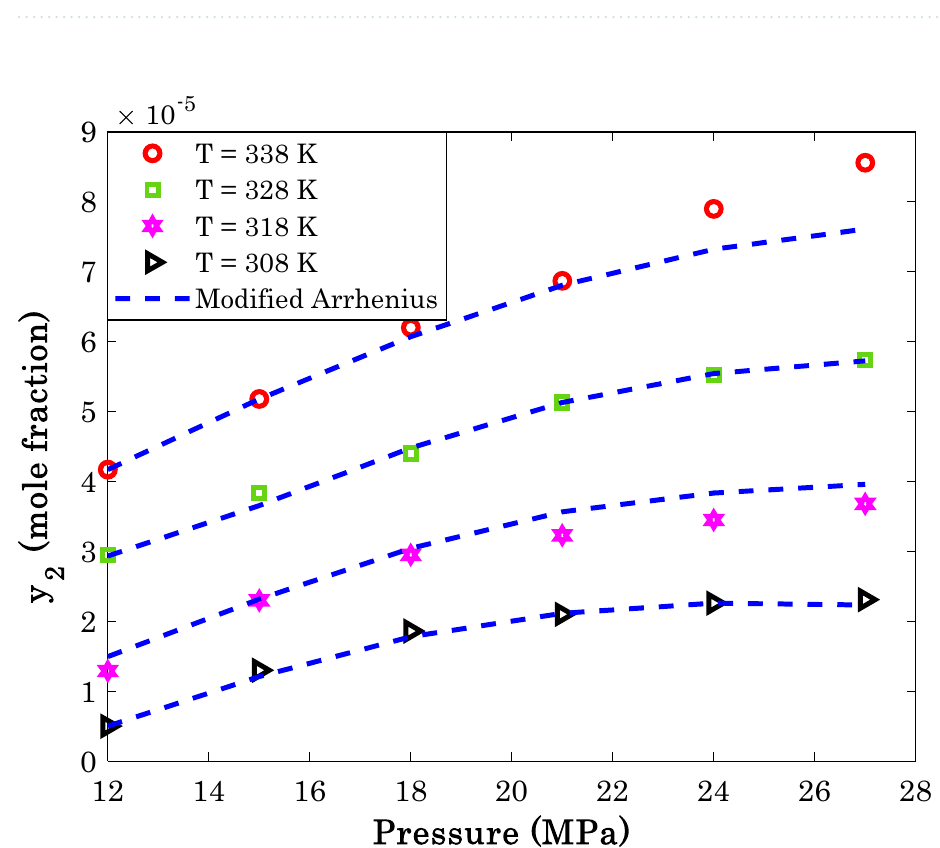
Figure 11. Variation of the sunitinib malate solubility in the supercritical CO 2 as a function of operating pressure and